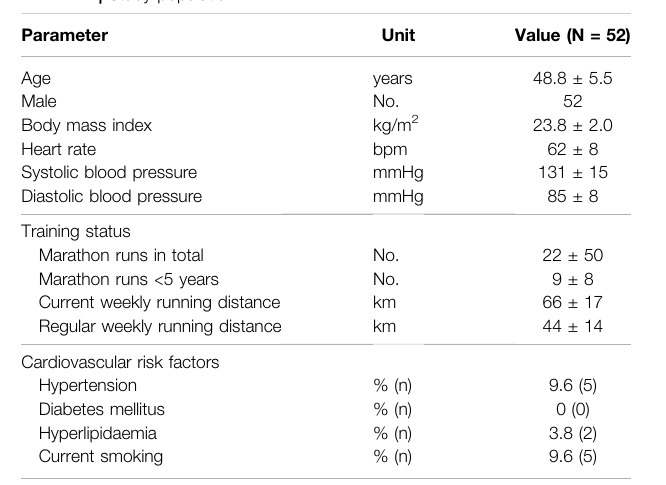
ICAM-1 expression. DAPI, Hoechst, and F-actin Phalloidin